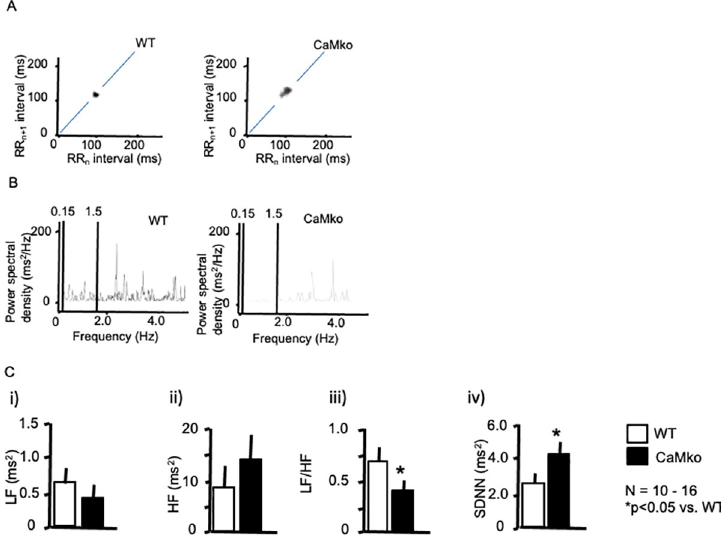
plotted, along with the nth+1 R-R interval, against the nth R-R period. Note the marked scattering of CaMKIV-null mice. B) Representative power spectral analysis of wild-type (left panel) and CaMKIV-null mice (right panel). C)